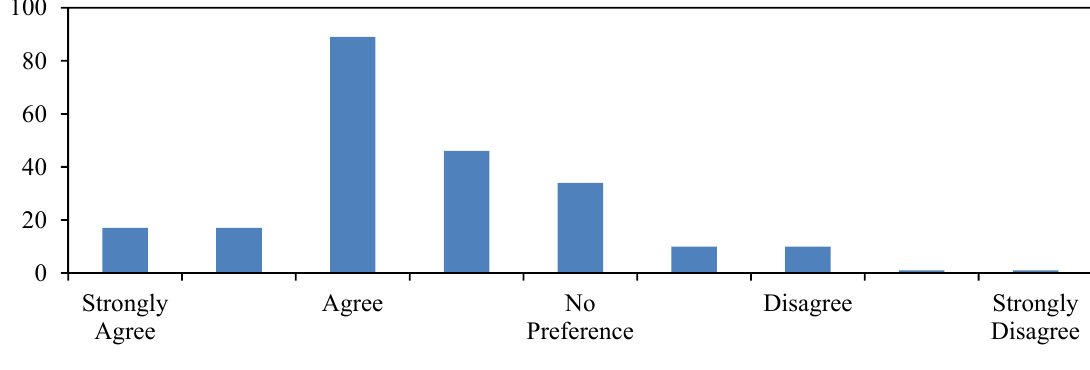
Figure 9. Graph of responses to the statement “I would trust computer analysis of data if the software had been tested on Earth and its analysis had been compared to traditional